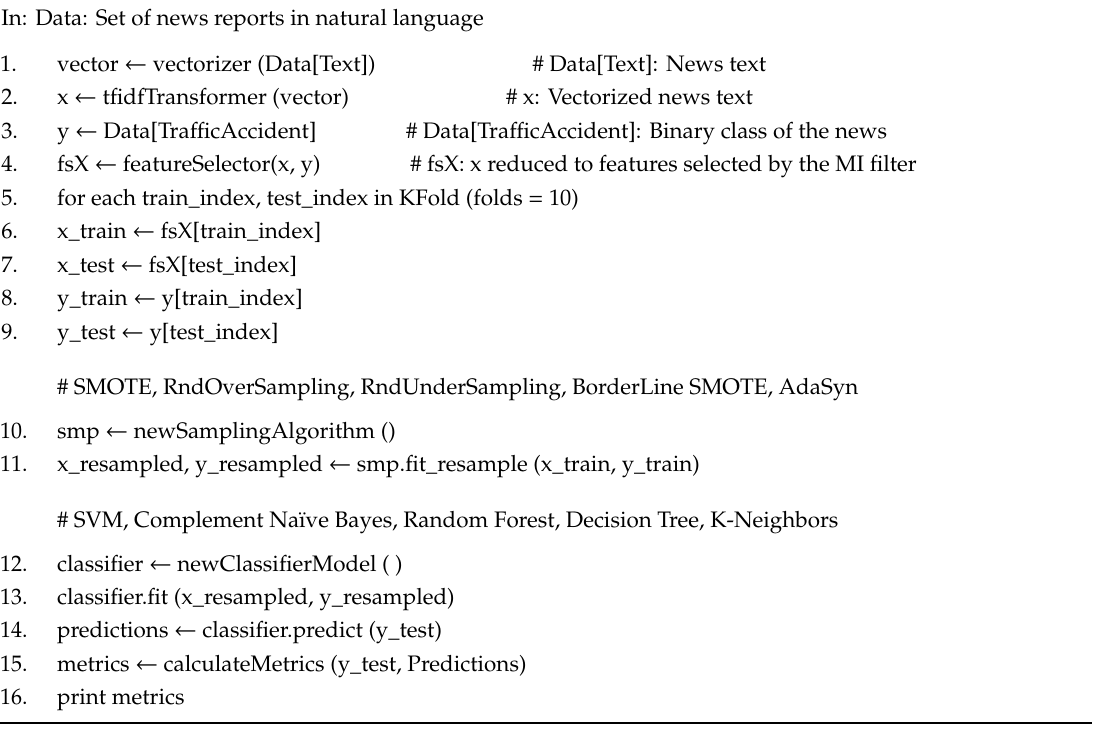
Algorithm 1 Pseudocode of the knowledge-discovery